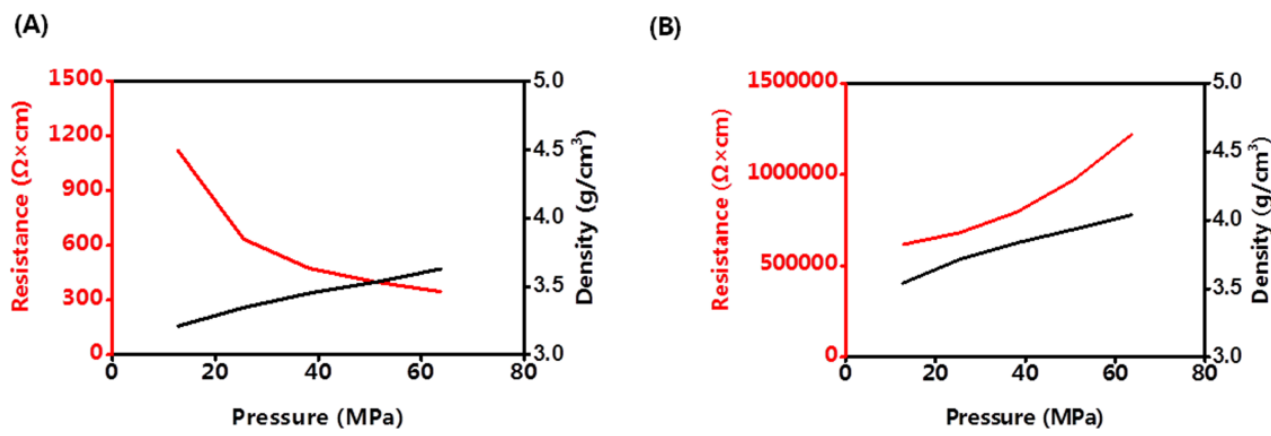
Figure 5. Volume resistance and density of LLZO&LNO@LCO ( A ) and LCO ( B ) under different pressures.